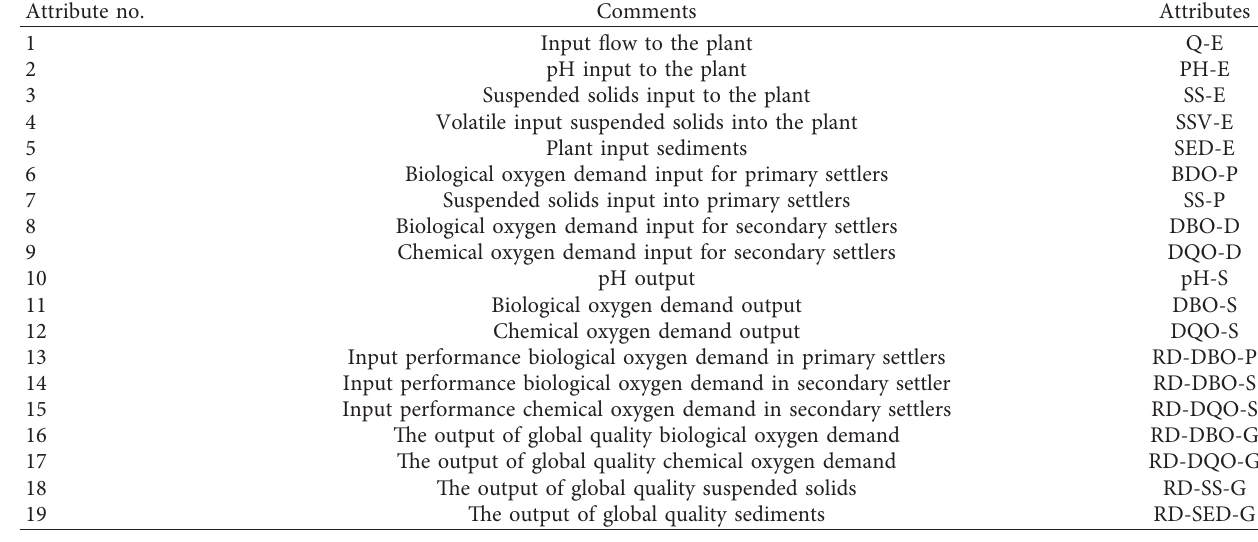
Table 1: Variables selected for the soft